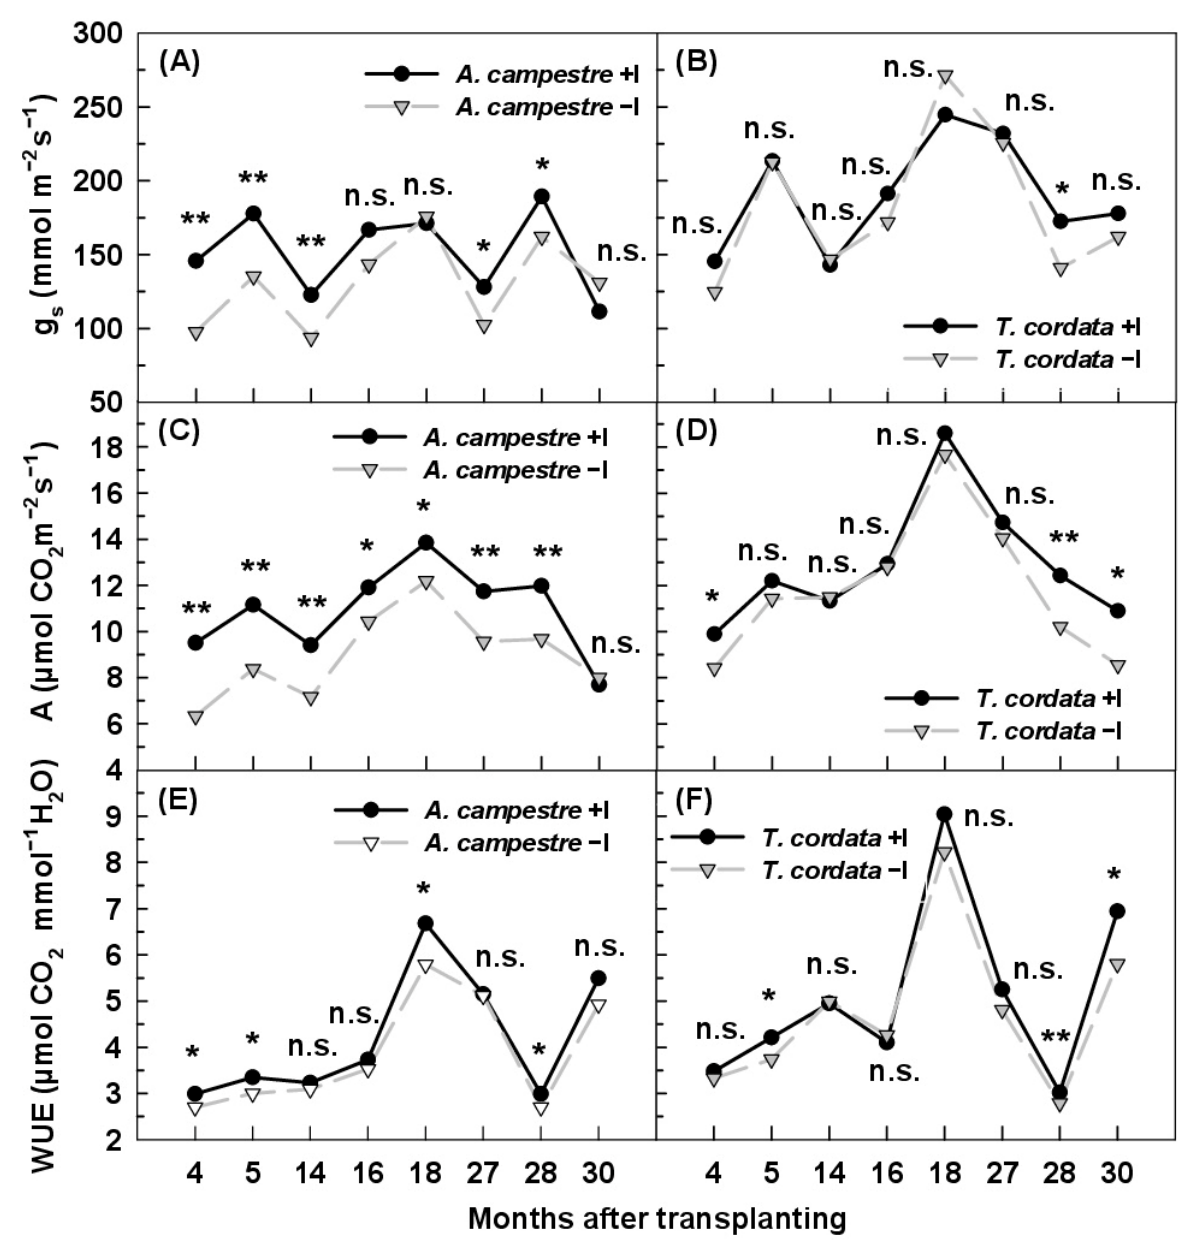
Figure 2. Effect of mycorrhizal inoculation in the nursery on stomatal conductance (g s , mmol m − 2 s − 1 ), carbon dioxide assimilation (A, μ mol CO 2 m − 2 s − 1 ) and water use efficiency (WUE, μ mol CO 2 mmol − 1 H 2 O) of Acer campestre L. ( A , C , E ) and Tilia cordata Mill. ( B , D , F ) transplanted in the field. Within each panel and sampling date, * and ** indicate significant differences between +I (inoculated) and − I (non-inoculated) plants at p ≤ 0.05 and p ≤ 0.01, respectively; n.s. indicates no significant differences.